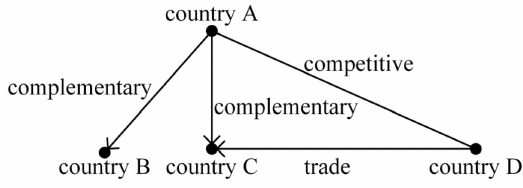
Figure 1. Diagram of the complex relations between